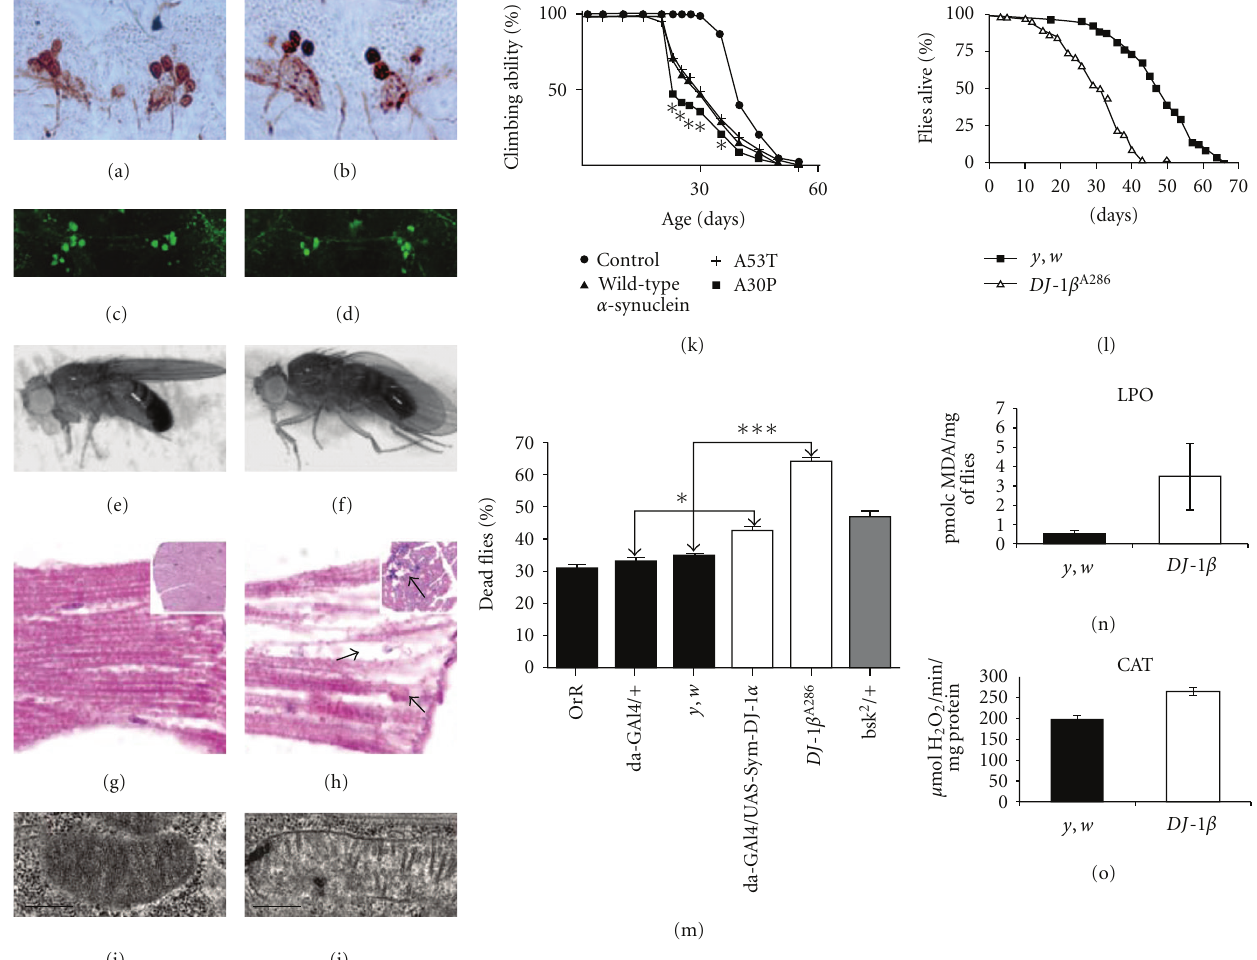
Figure 1: Representative phenotypes found in di ff erent Drosophila PD models. (a)–(d) DA neuron loss detected in Drosophila adult brains by immunostainings with anti-TH antibody, which specifically recognizes these neurons, in para ffi n sections (a, b) or whole-mount brains (c, d). A reduction in the number of DA neurons is observed in both Ddc-GAL4 / DJ-1 α RNAi (b) [50] and Ddc-GAL4/UAS- α -Synuclein (d) [51] brains when compared to age-matched Ddc-GAL4 /+ controls (a, c). (e)–(j) Examples of phenotypes observed in parkin LOF mutants (f, h, j) compared to controls (e, g, i). They include downturned wings (f), muscle degeneration (h), and abnormal mitochondrial morphology (j) [52]. (k) Premature loss of climbing ability in transgenic flies expressing wild-type, A30P, and A53T mutant forms of α -Synuclein [34]. (l) Reduced lifespan of DJ-1 β mutants compared to y, w control flies cultured under the same conditions. (m) Elevated sensitivity to paraquat stress in DJ-1 α and DJ-1 β mutant flies, represented by calculating the percentage of dead flies after feeding 15mM for 18h [53]. (n)–(o) Quantification of oxidative stress levels in 1-2-day-old DJ-1 β mutants and age-matched y, w control flies. DJ-1 β mutants show an increase in lipid peroxidation (LPO) product malondialdehyde (MDA) (n). Catalase (CAT) enzymatic activity is also increased (o)